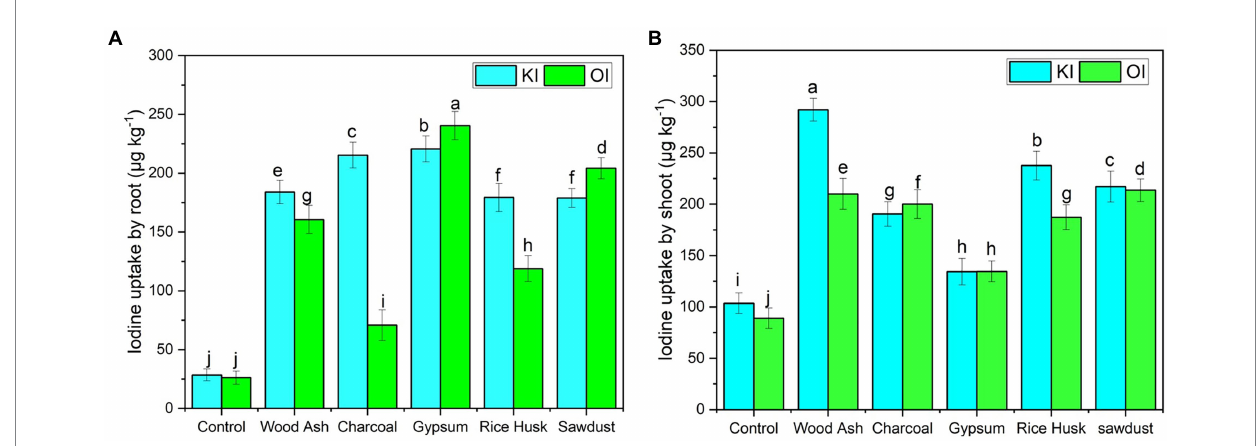
FIGURE 2 Iodine concentrations in the shoots and roots of coriander plants after soil amendments as affected by (A) potassium iodide (KI) and (B) organic iodine